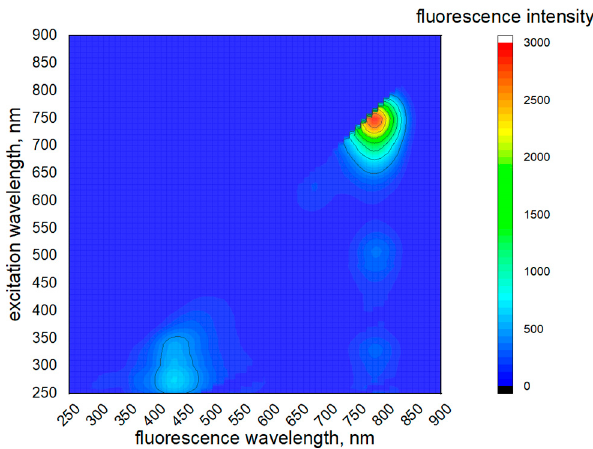
Figure 2. 3D excitation/fluorescence spectrum of BD in DCM.